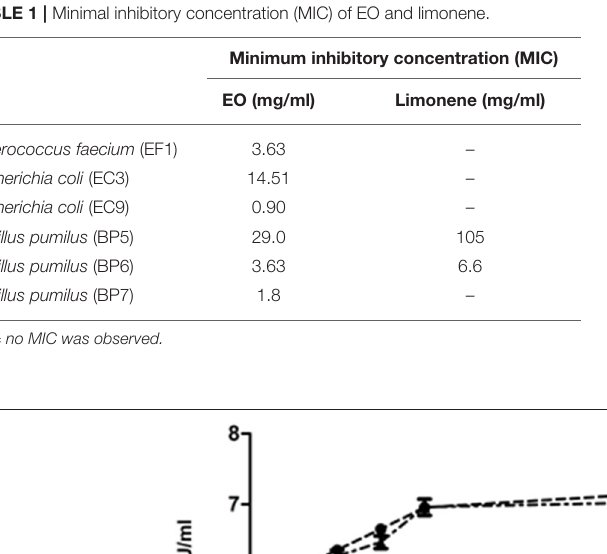
Frontiers in Veterinary Science |